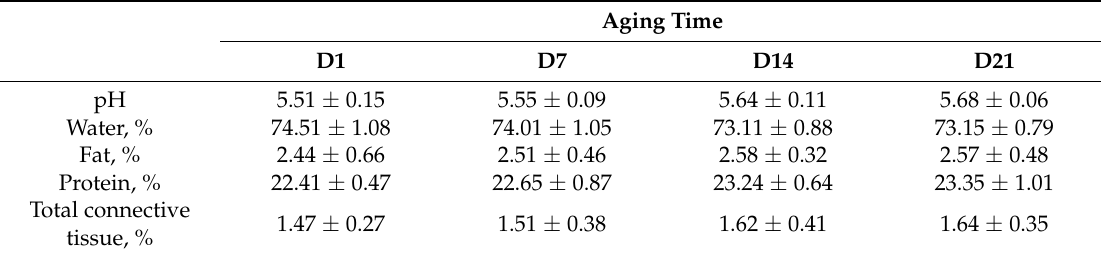
Table 1. Mean ± standard deviation of pH and the basic meat composition of beef longissimus lumborum (LL) muscle (N = 178 for each aging